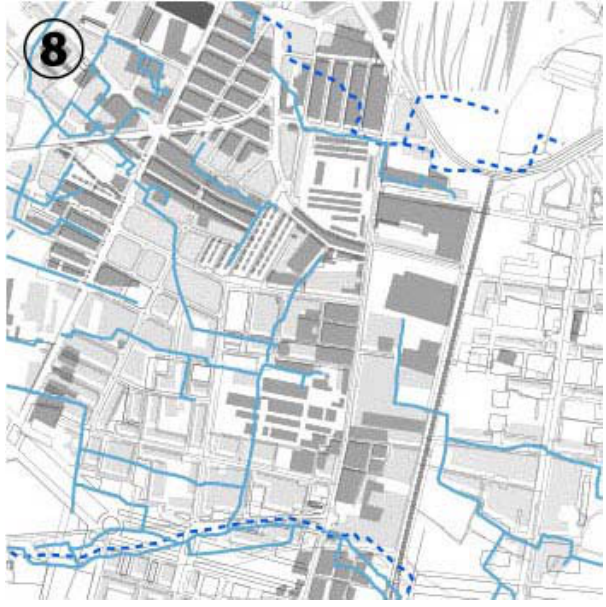
Figure 13. In the area labeled ⑧, the canals developed during the period between 1883 and